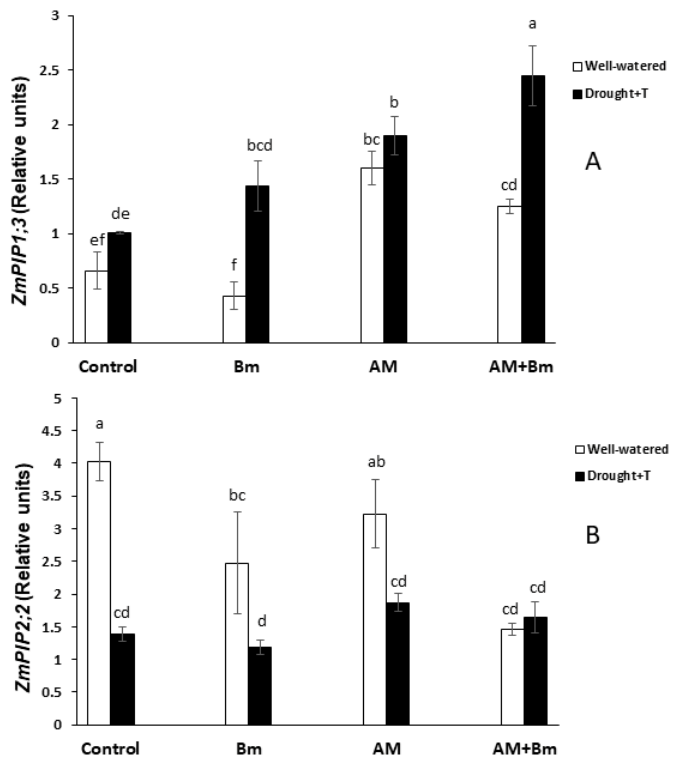
Figure 6. Expression of ZmPIP1;3 ( A ) and ZmPIP2;2 ( B ) in roots of maize plants inoculated or not (control) with a PGPR strain of Bacillus megaterium (Bm), with the arbuscular mycorrhizal fungus Rhizophagus irregularis (AM) or with both microorganisms (AM + Bm). Plants were cultivated under standard ambient temperature and well-watering conditions (well-watered) or subjected to a combined drought and high temperature stress (drought + T) for 15 days before harvest. Data represent the means (n = 3) ± S.E. Different letters indicate significant differences between treatments ( p < 0.05) based on Duncan’s